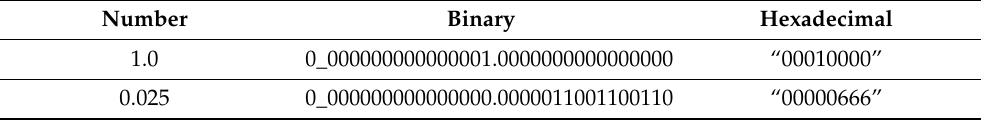
Table 2. Fixed-point 32-bit number